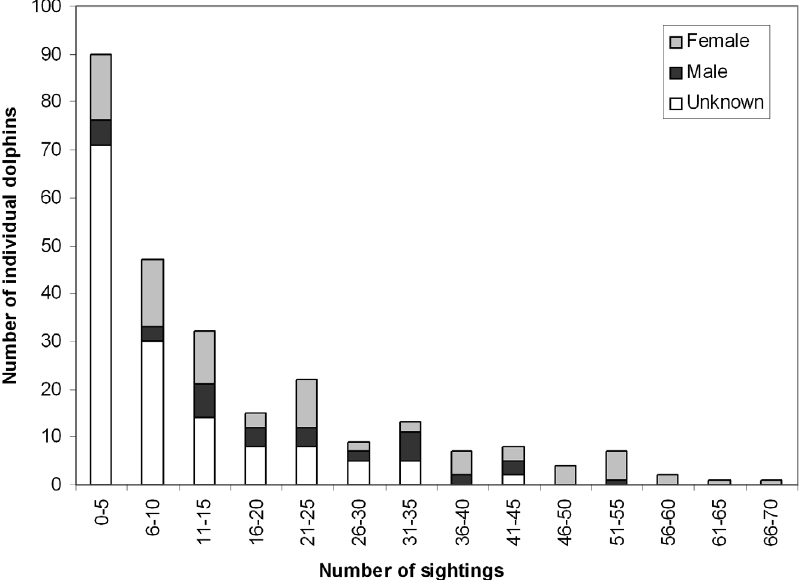
Figure 2. Sighting frequency of individually identified bottlenose dolphins (non-calves) March 2007-November 2009.